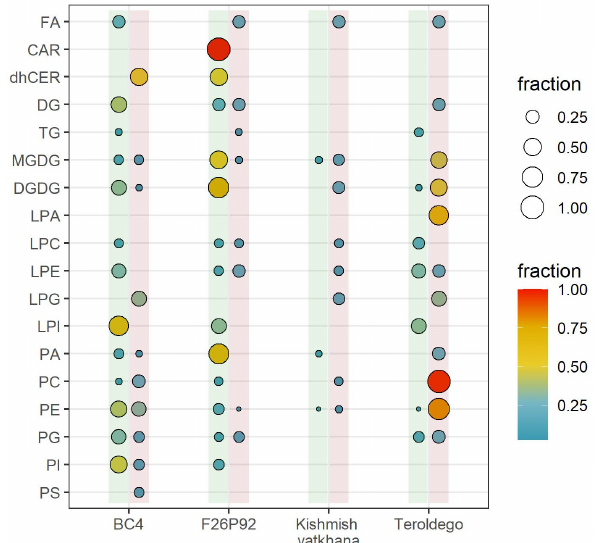
Figure 1. Visualization (in percentage points) of all classes of lipids that were highly modulated in response to E. necator infection. Based on the total number of detected and semi-quantified lipids, the size and color intensity of the dots are proportionate to the estimated percentage of lipid class modulation in each genotype in both years. The dots inside the vertical lines show the percentages of lipid modulation (green = at 24 hpi, red = at 48 hpi).